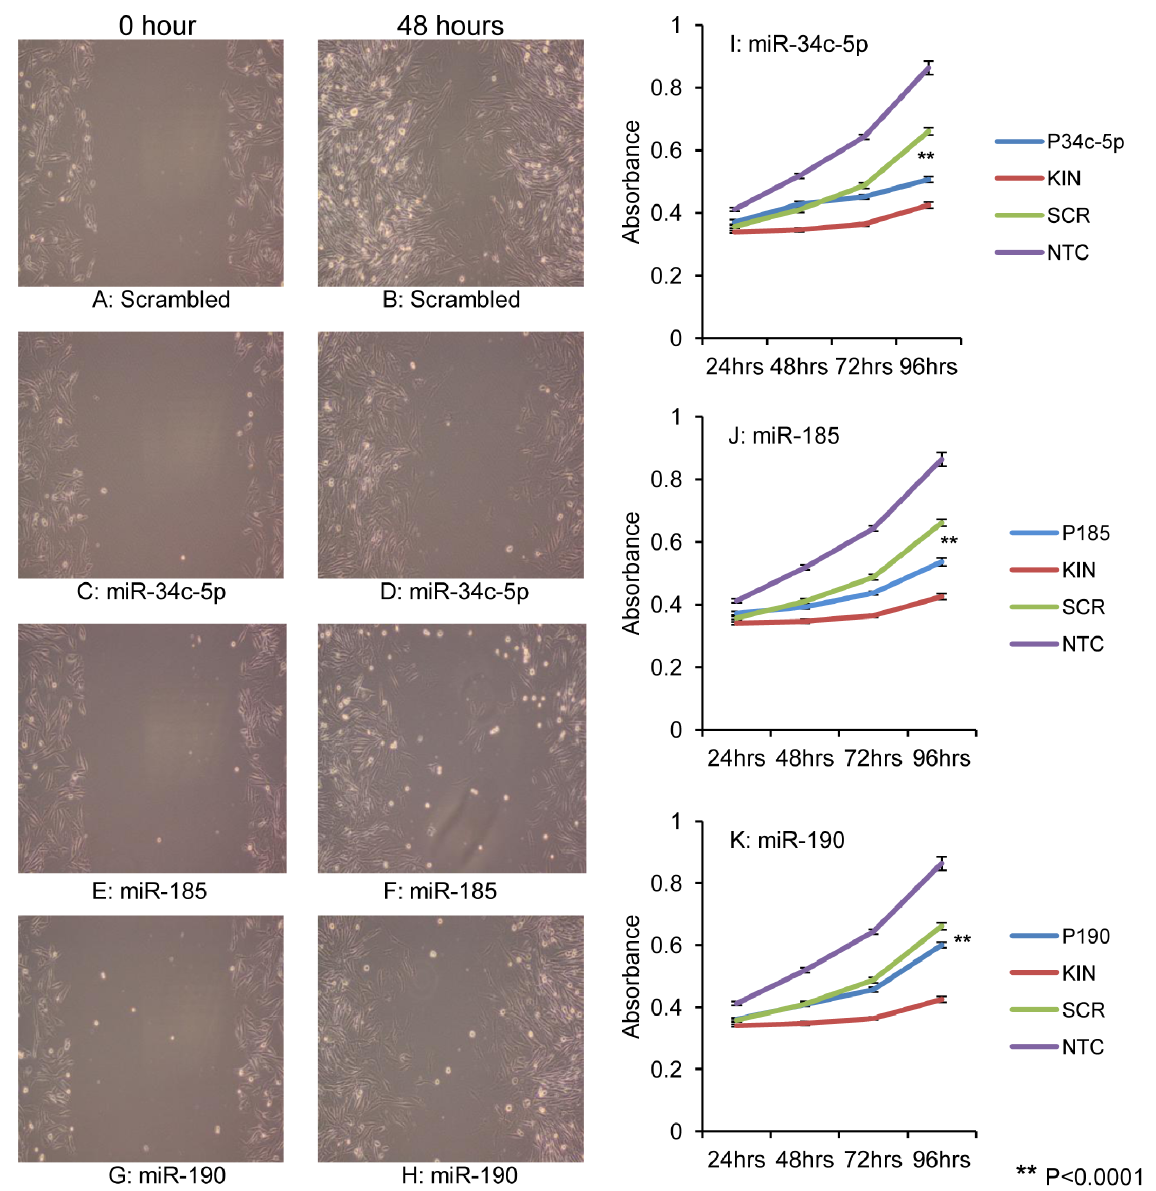
Figure 5. Functional studies of selected differentially expressed miRNAs. Transfection with miR-34c-5p, miR-190 and miR-185, (all of which are expressed at higher levels in pediatric compared with adult mutant cases), show decreased wound healing compared to the SCR control 48 hours after scratch assay (Figures A–H). Ectopic expression of miR-34c-5p, miR-190 and miR-185 showed a significant decrease in cell proliferation at 96 hours, as measured using an MTS assay, compared to the SCR control (Figures I–K). KIN=siKinesin (positive control for reduced cell proliferation), SCR=scrambled oligonucleotide control, NTC=non-transfected control.